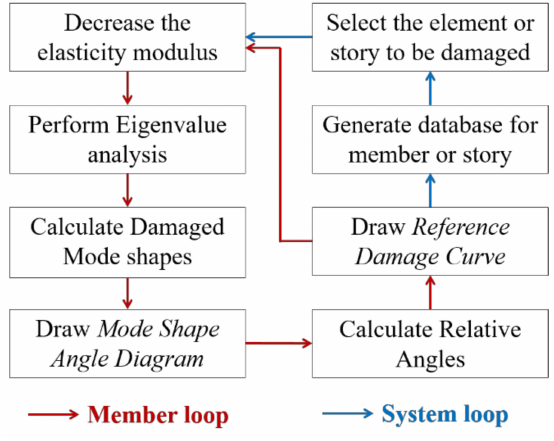
Figure 7. The methodology followed in the damage simulations.